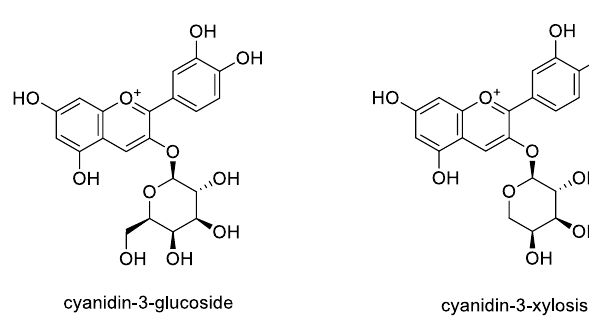
Figure 5. Chemical structures of compounds isolated from A. melanocarpa fruits Table 3. Content of phenolic compounds in four A. melanocarpa extracts (T1~T4) as determined by